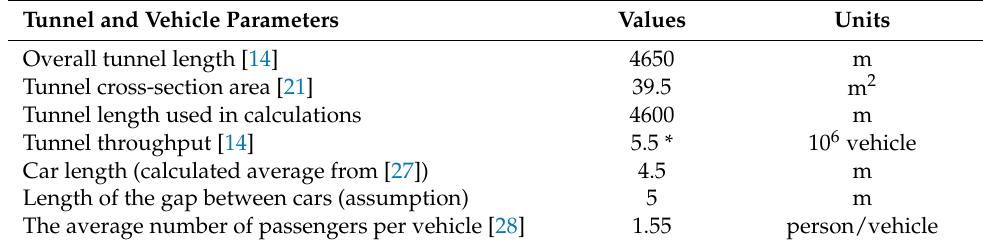
Table 2. Tunnel and vehicle parameters and the average number of passengers per vehicle. Tunnel and Vehicle Parameters Values Units Overall tunnel length [14] 4650 m Tunnel cross-section area [21] 39.5 m 2 Tunnel length used in calculations 4600 m Tunnel throughput [14] 5.5 * 10 6 vehicle Car length (calculated average from [27]) 4.5 m 5